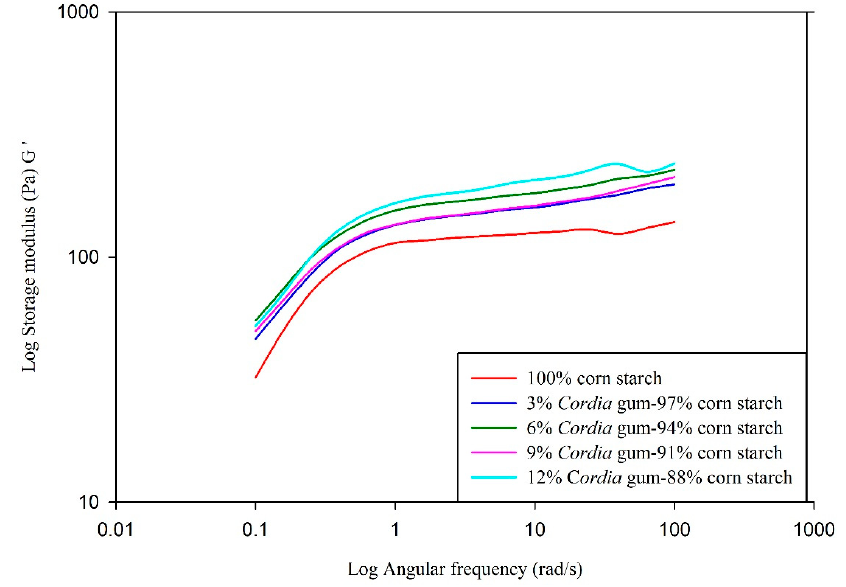
Figure 2. E ff ect of gum Cordia on the storage (elastic) modulus (G (cid:48) ) of corn starch Figure 2. Effect of gum Cordia on the storage (elastic) modulus (G ′ ) of corn starch gels.